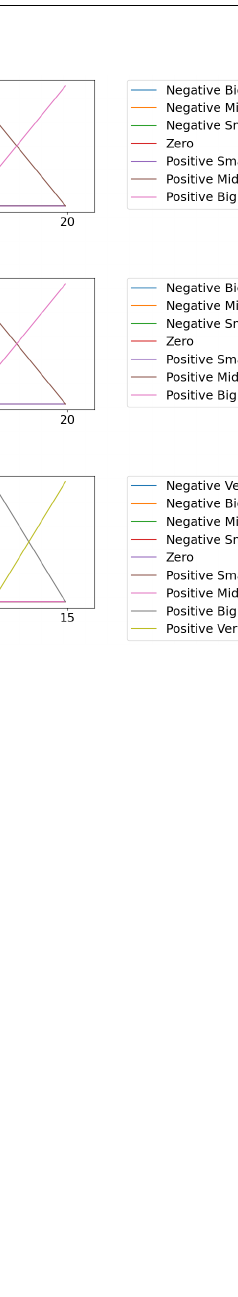
Figure 14. Surface of fuzzy inference